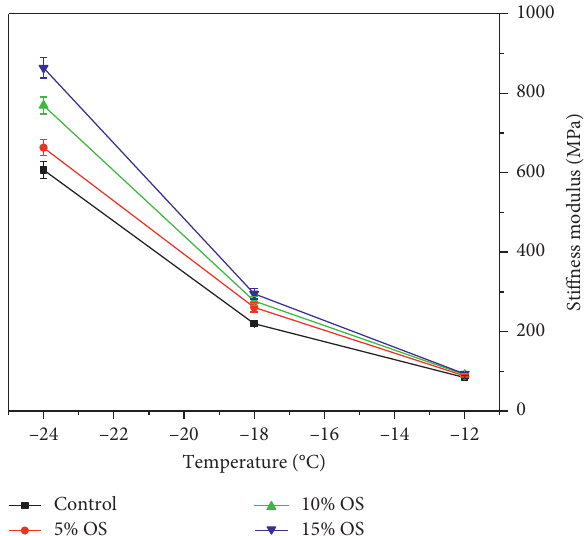
Figure 10: S-curve of asphalt binder for studied materials at low